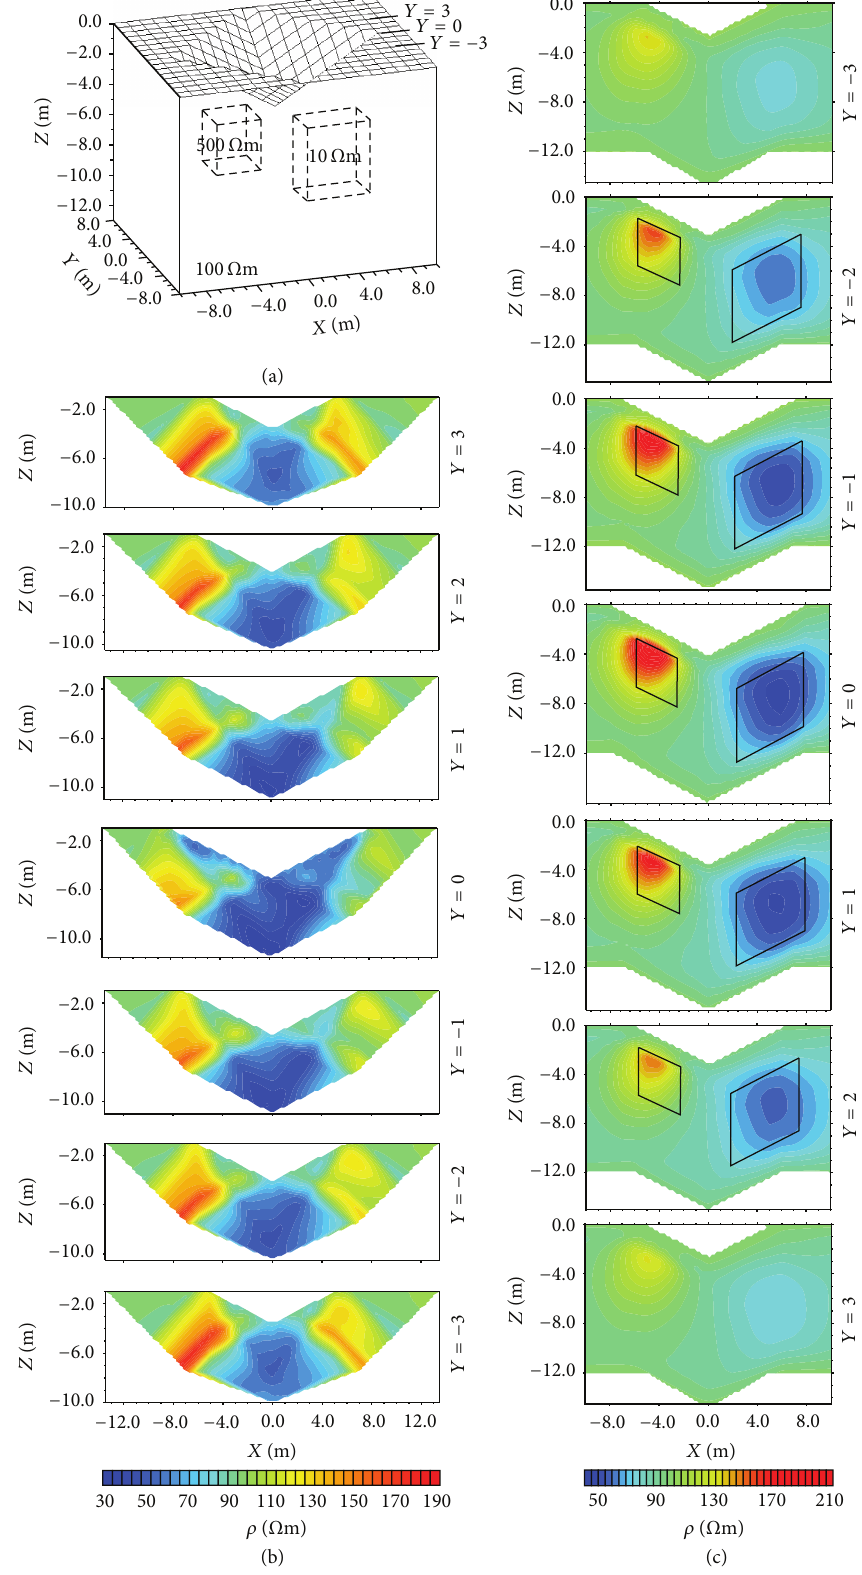
Figure 7: The inversion result for a complex model. (a) A model with two bodies under a valley. (b) Slices view of apparent resistivity. (c) Slices view of 3D inversion